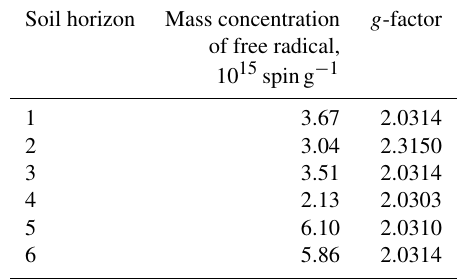
Table 5. Mass concentration of free radicals in humic